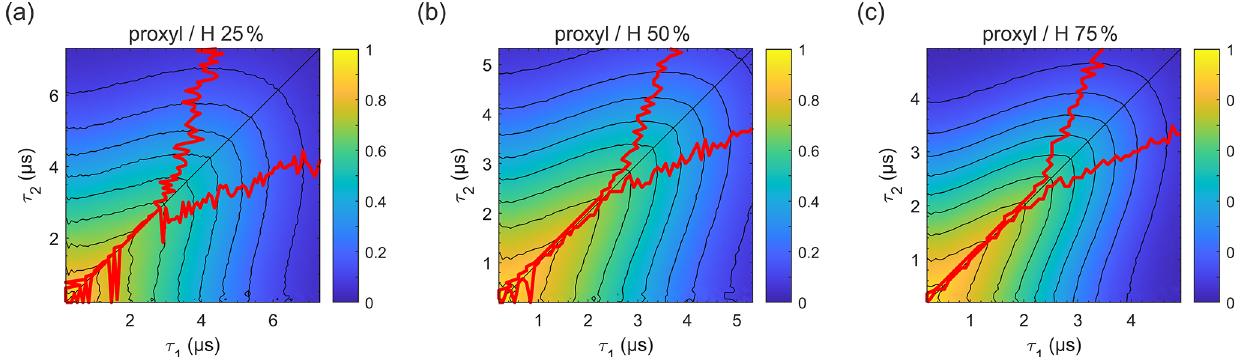
Figure 5. Refocused echo decay for 100µM 3-maleimido-proxyl in H 2 O / glycerol solvents (80 : 20 v/v ) with varying degrees of solvent protonation at 25K, i.e. (a) 25%, (b) 50%, and (c) 75%. The red lines indicate the location of the maxima along τ 1 for fixed τ 2 (upper line) and vice versa (lower line). Plots for 100% and 0% solvent protonation are shown in Figs. 3a and 4a, respectively.